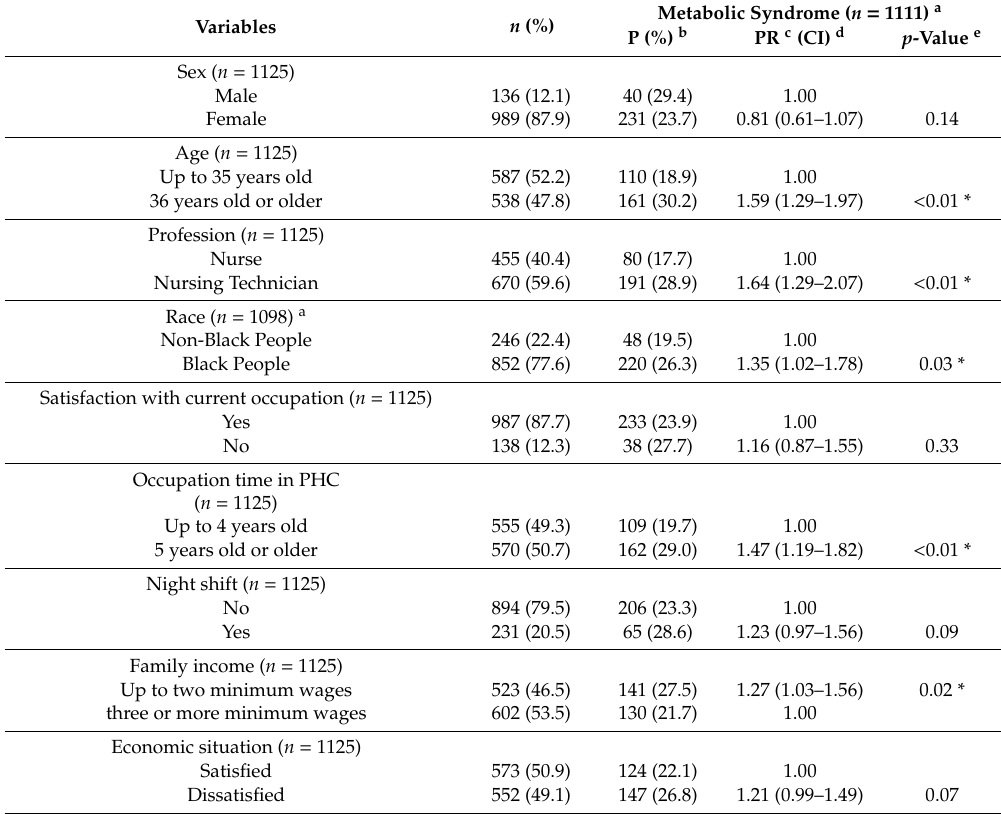
Figure 3. Prevalence of metabolic syndrome in nursing professionals of primary health care distributed per mesoregions of Bahia, Brazil, 2018. Table 1. Prevalence of metabolic syndrome according to sociodemographic and labor variables in Primary Health Care Nursing Professionals, Bahia, Brazil, 2018, ( n =